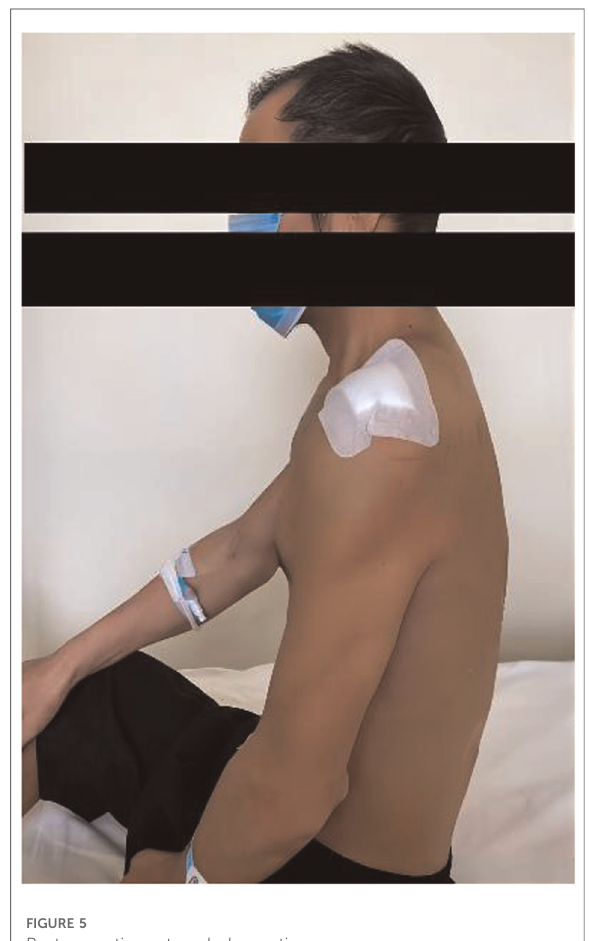
FIGURE 5 Post-operative external